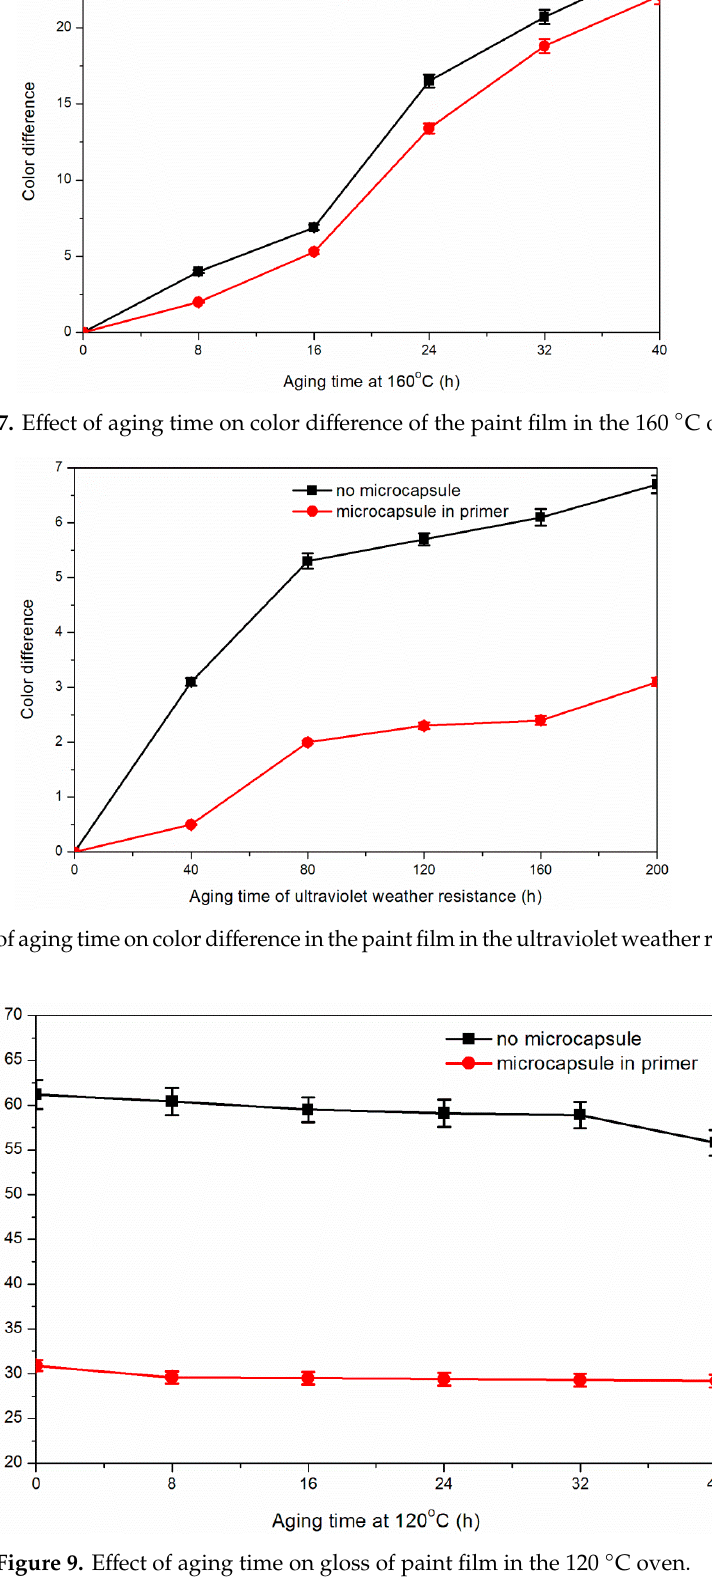
Figure 10. Effect of aging time on gloss of the paint film in the 160 °C oven.